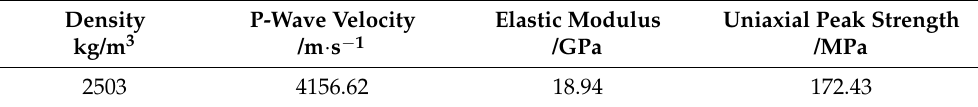
Figure 2. Specimen preparation: ( a ) sampling location; ( b ) stratigraphy formation; ( c ) shale layer in field; ( d ) prepared specimens. Table 2. Physical and mechanical properties of the shale samples.